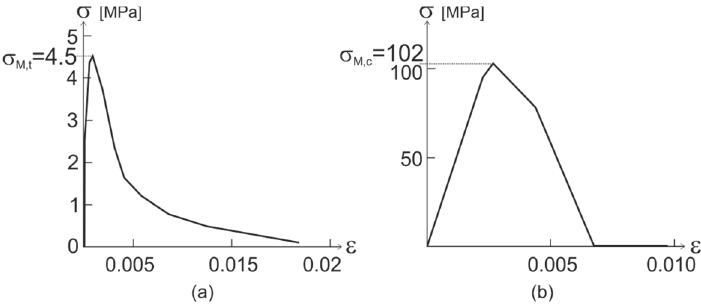
Figure 4. Tensile ( a ) and compressive ( b ) response curves.